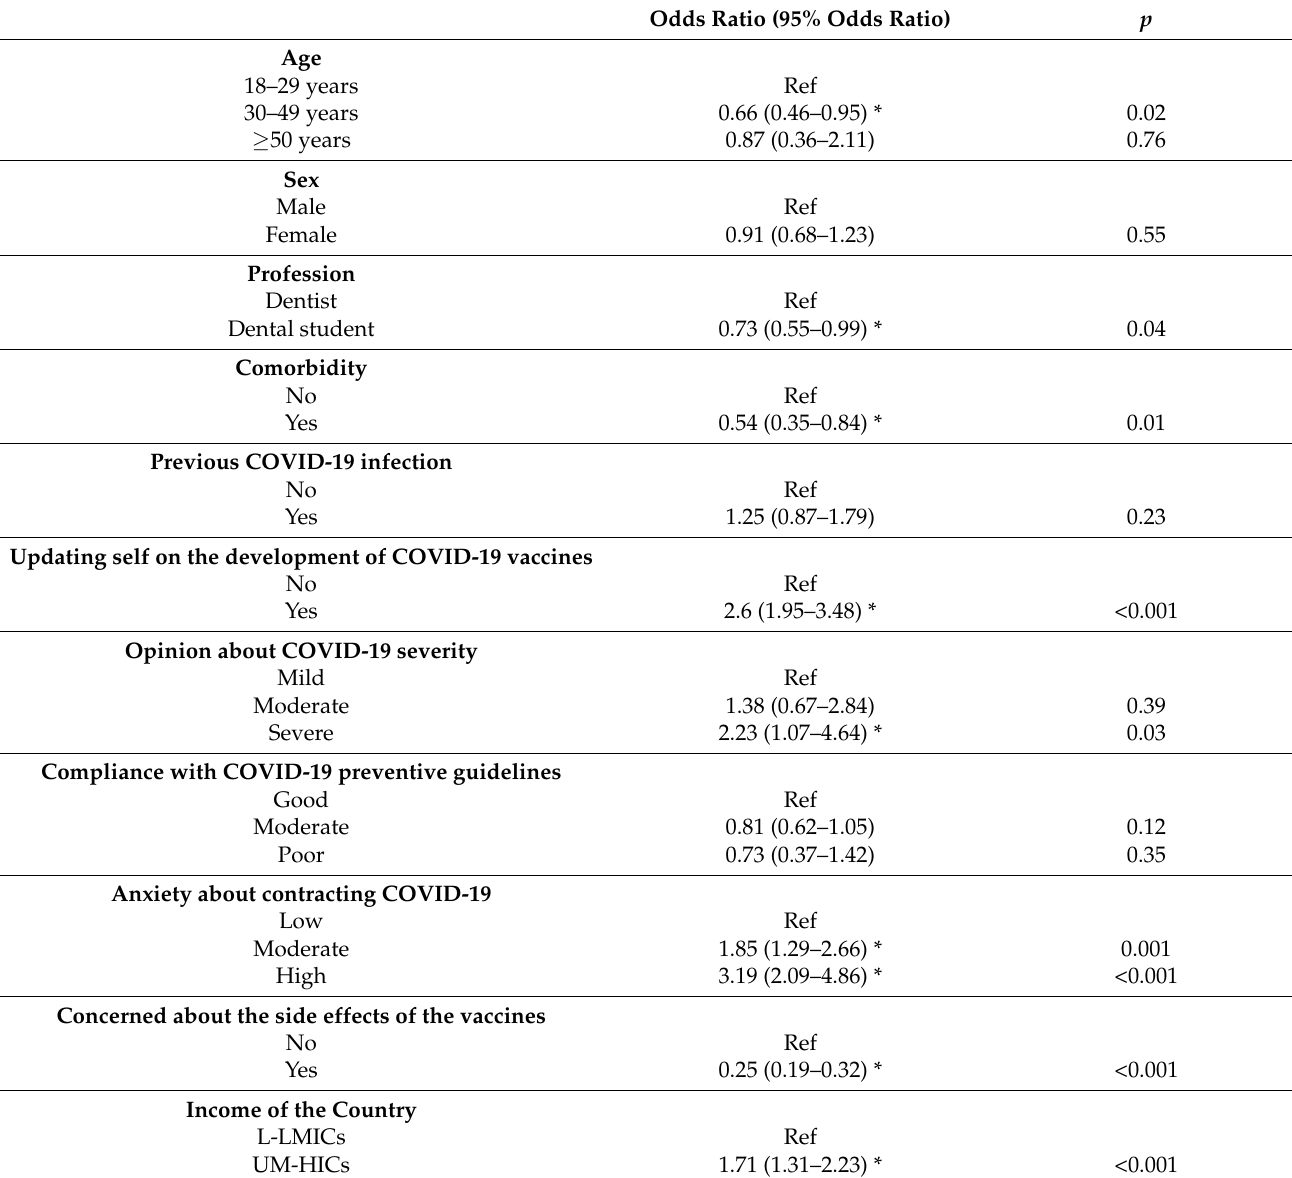
Table 5. Predictors of agreement to accept a COVID-19